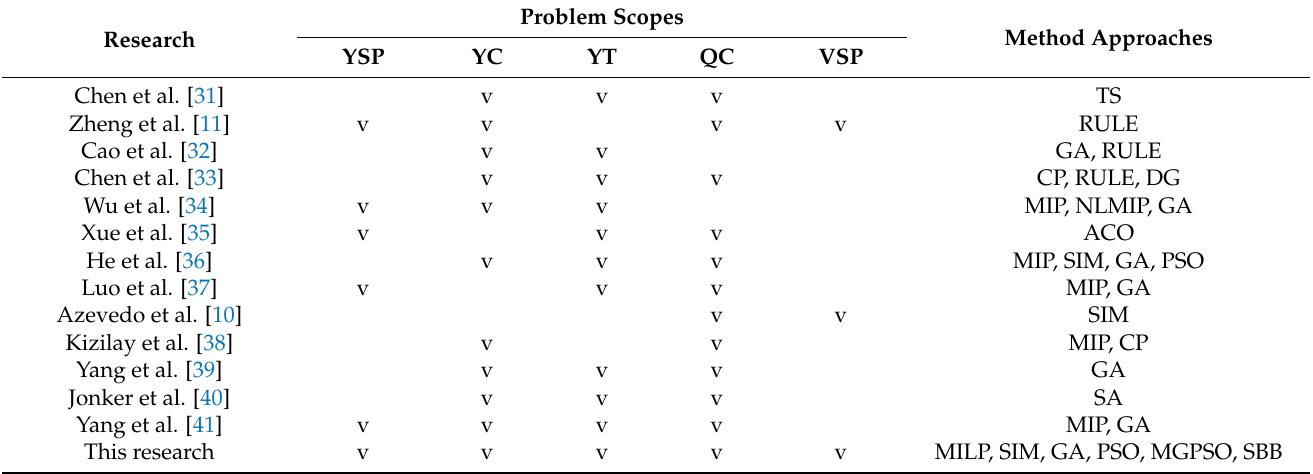
Table 1. The comparison of some integrated studies of container terminal